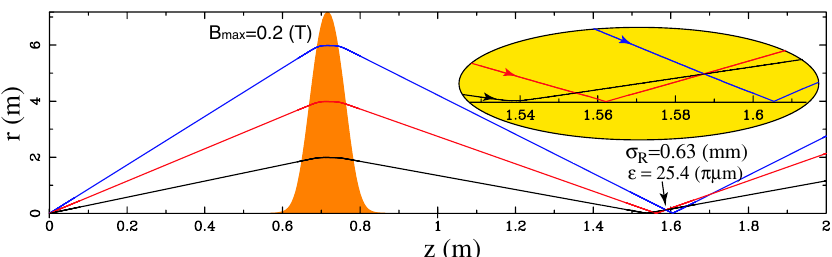
FIG. 9. (Color) Probe particle trajectories of the beam in the rf lens ( != 2 (cid:5) (cid:4) 2 : 47 GHz ).